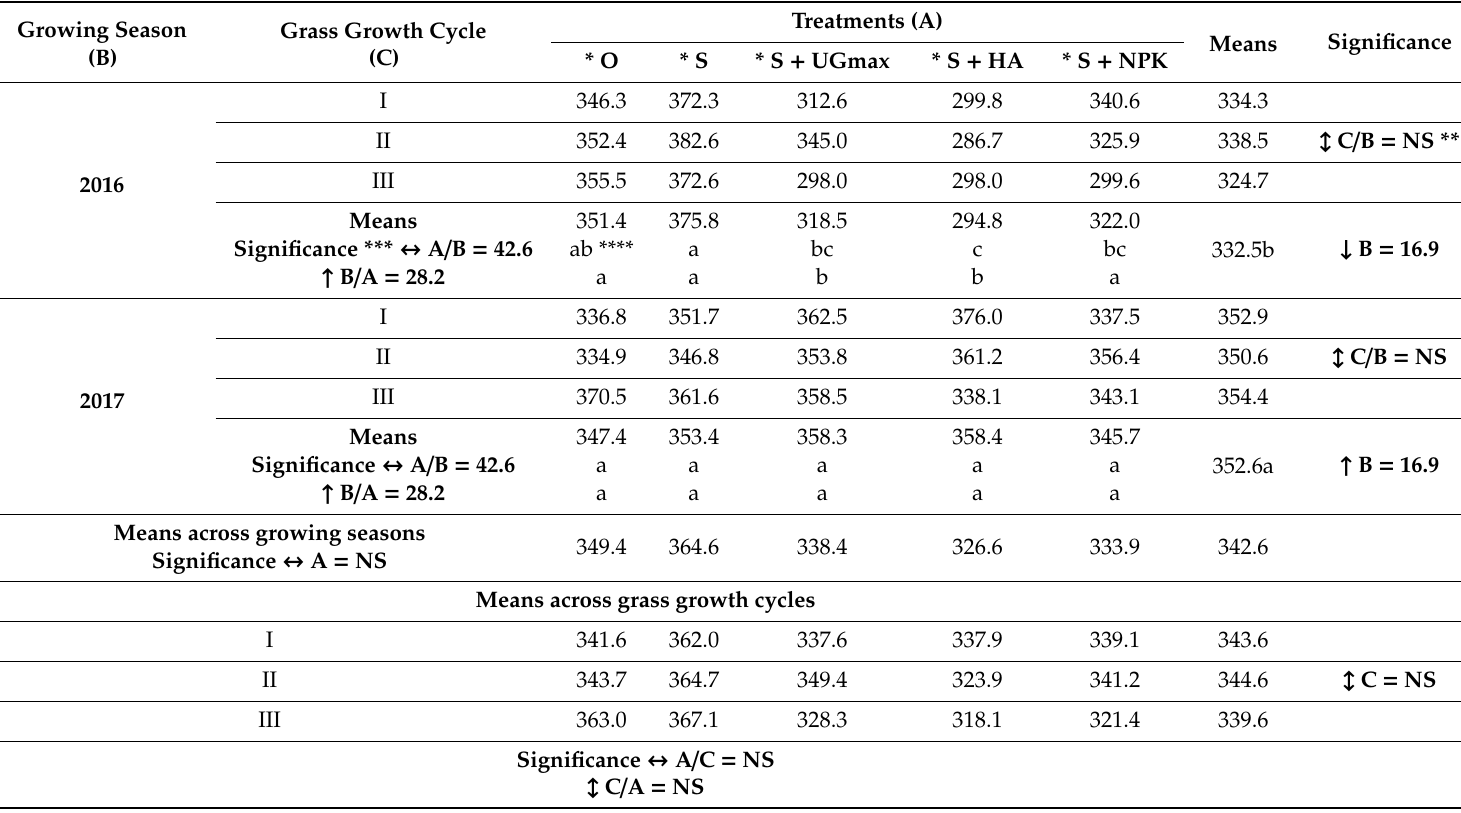
Table 5. The e ff ect of treatments on mean acid detergent fiber (ADF) content in Festulolium braunii dry matter across grass growth cycles and growing seasons (g · kg − 1 ). Growing Season